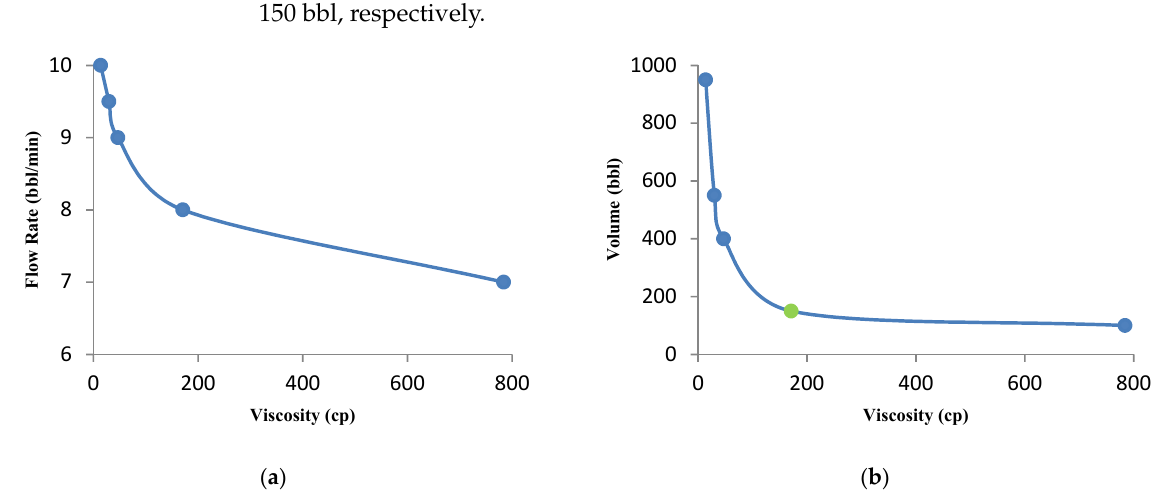
Table 3. Property of three acid systems types studied [37].